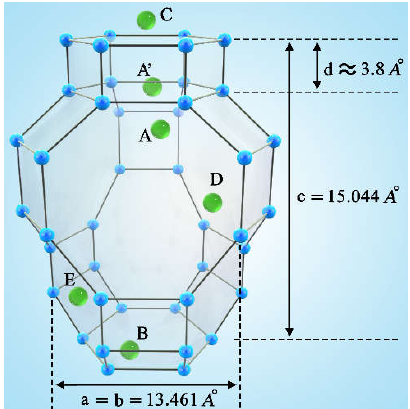
Figure 2. Schematic drawing of the SSZ-13 hexagonal unit cell structure and possible Cu 2+ locations (A, A’, B, C, D, E represent the possible Cu 2+ locations). (A, A (cid:48) , B, C, D, E represent the possible Cu 2+